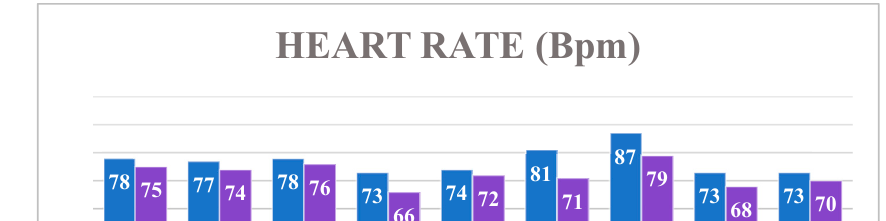
Figure 2. Trend of 6mwt and fss scoring.